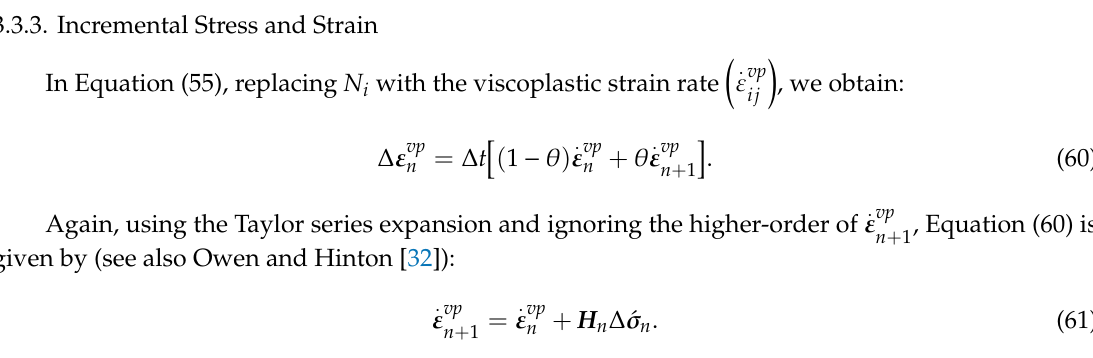
Figure 7. E ff ect of ∆ t for the solution using θ -method ( a ) Explicit and ( b ) Figure 7. Effect of ∆ t for the solution using θ -method ( a ) Explicit and ( b ) Implicit.